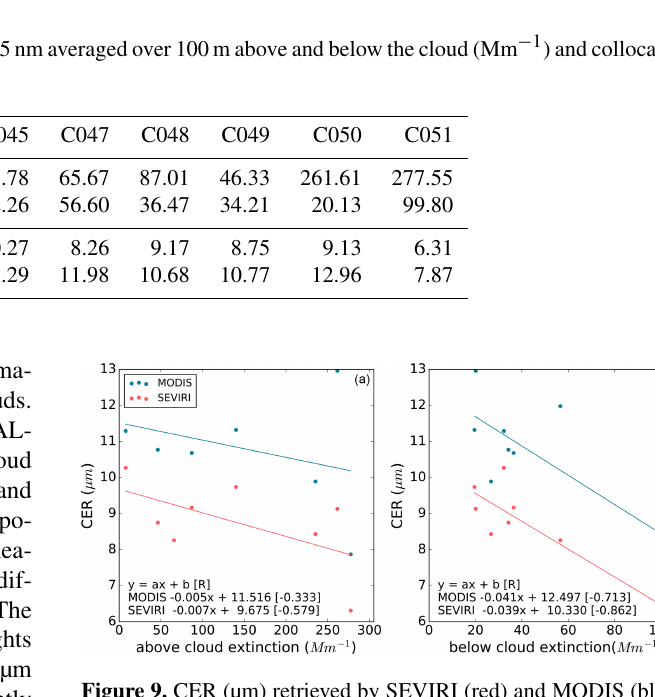
Figure 9. CER (µm) retrieved by SEVIRI (red) and MODIS (blue) as a function of the dry extinction (Mm − 1 ) measured by EXSCAL- ABAR at 405nm and averaged over 100m directly above (a) and below the cloud (b) . The linear regression fits are defined by the slope a , the intercept b and the Pearson’s correlation coefficient R